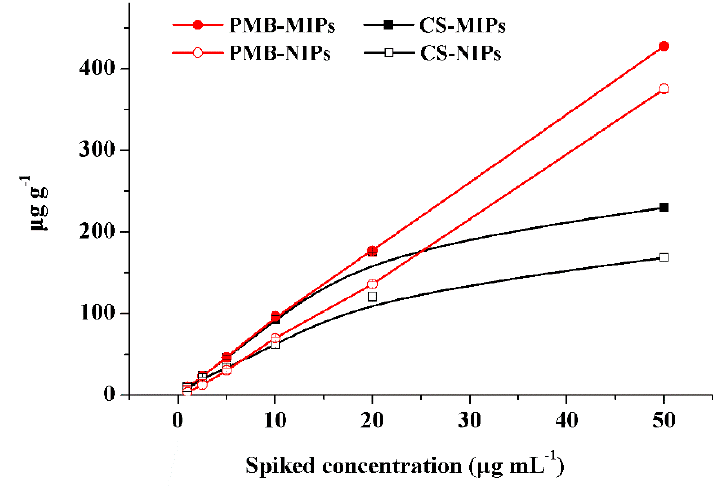
Figure 4. Adsorption curves of colistin (CS) and polymyxin B (PMB) on MIP and NIP.